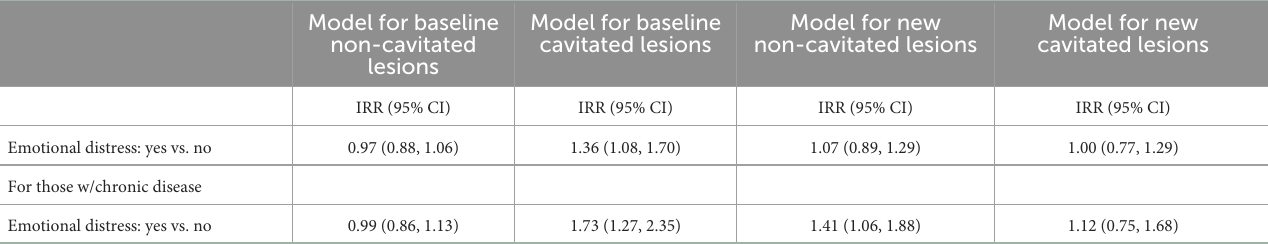
TABLE 3 Incidence rate ratio for dental caries by emotional distress from the multivariable regression analysis among African-American caregivers, Detroit, Michigan, 2002–2007.